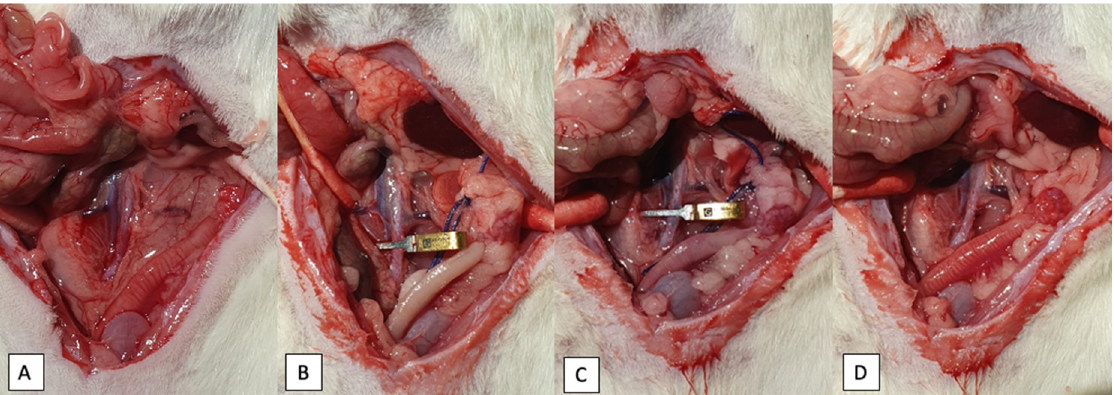
Figure 5. Blood flow changes in uterus during the experiment. ( A )—before ischemia; ( B )—start of ischemia; ( C )—before reperfusion; ( D )—start of reperfusion.